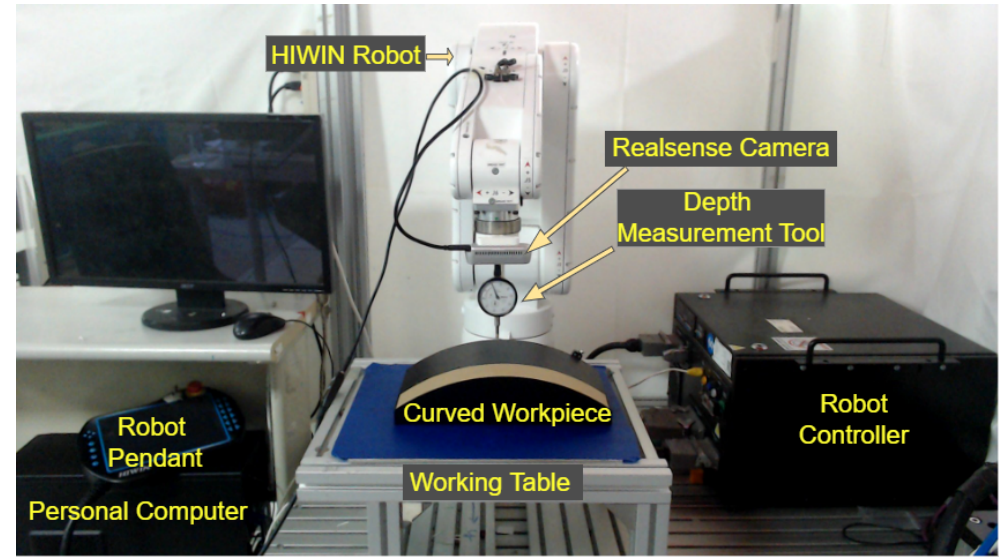
Figure 7. The experimental hardware used to evaluate the efficacy of the presented